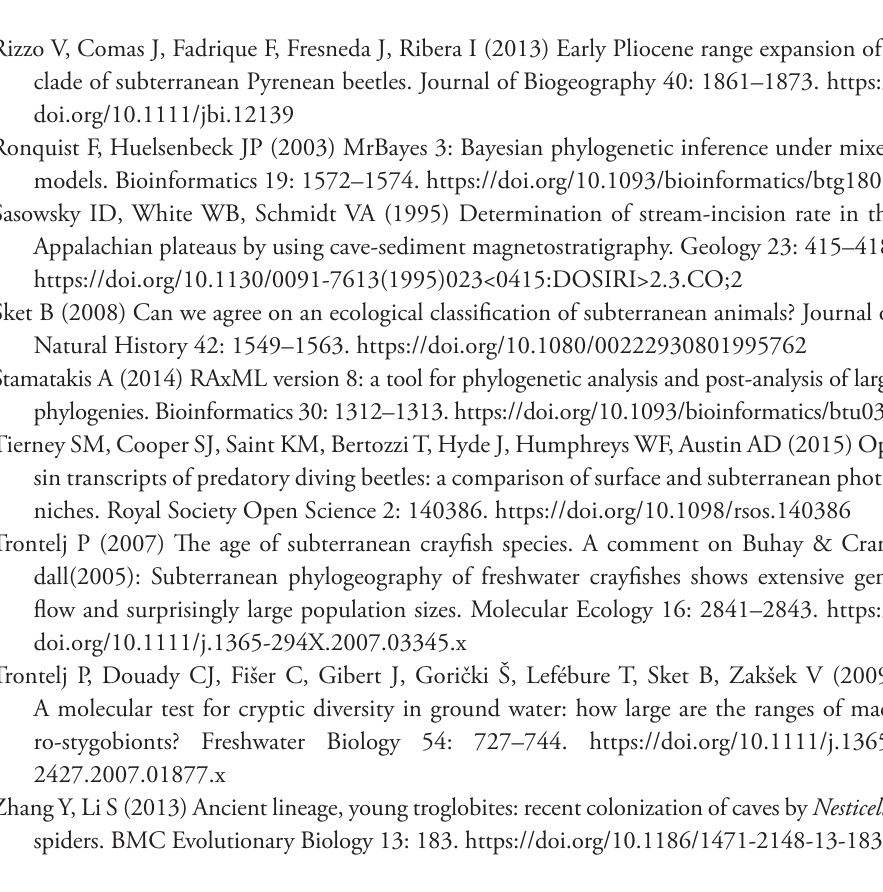
Table S1. Mean cox1 P-distances between specimens from the same